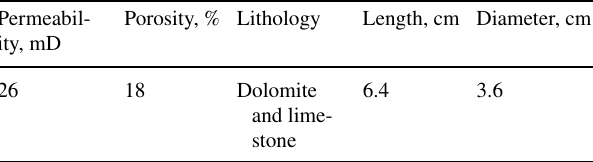
Table 1 The ion concentration of the synthetic brines